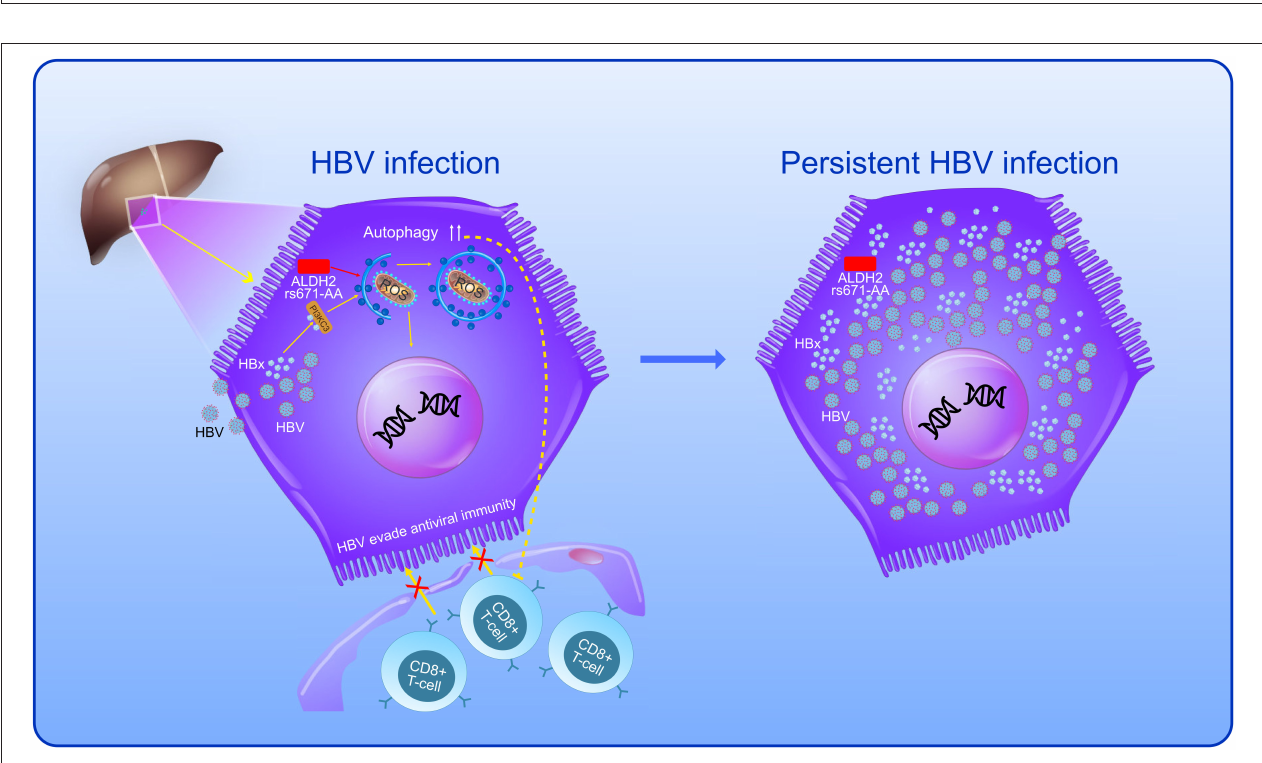
FIGURE 2 | (mean ± SD), unpaired t -test, and one-way ANOVA were used. (B) Comparison of HBV-DNA distribution among subjects with AA, AG, and GG genotypes at rs671 in the CHB group. Patients with CHB with rs671-AA genotype showed the highest proportion (58.97%) of HBV-DNA levels at more than 10 5